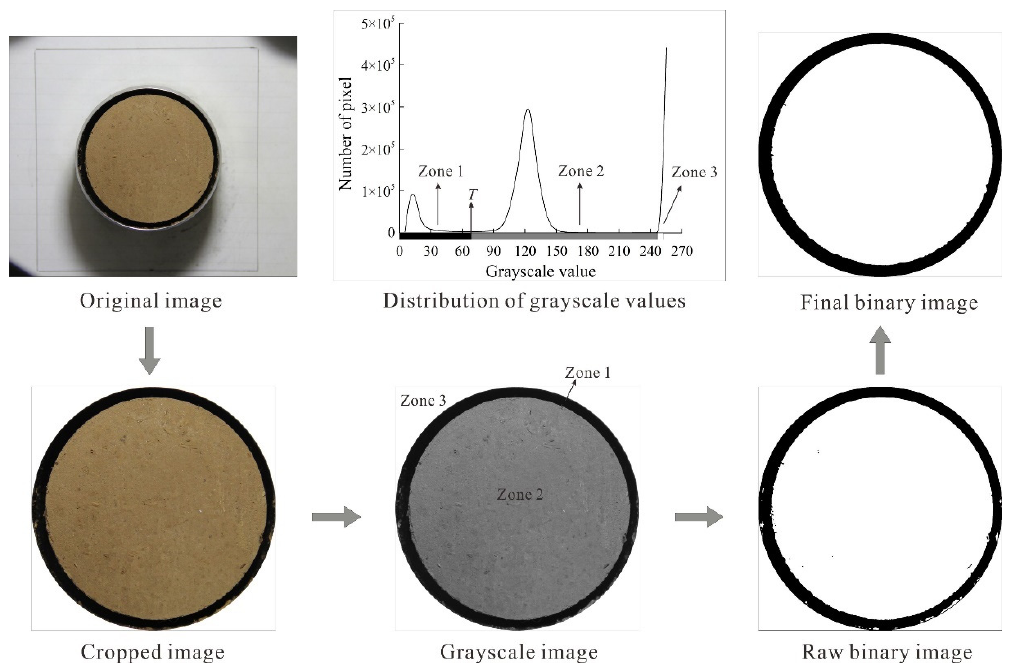
Figure 1. Diagrammatic sketch of digital image processing.